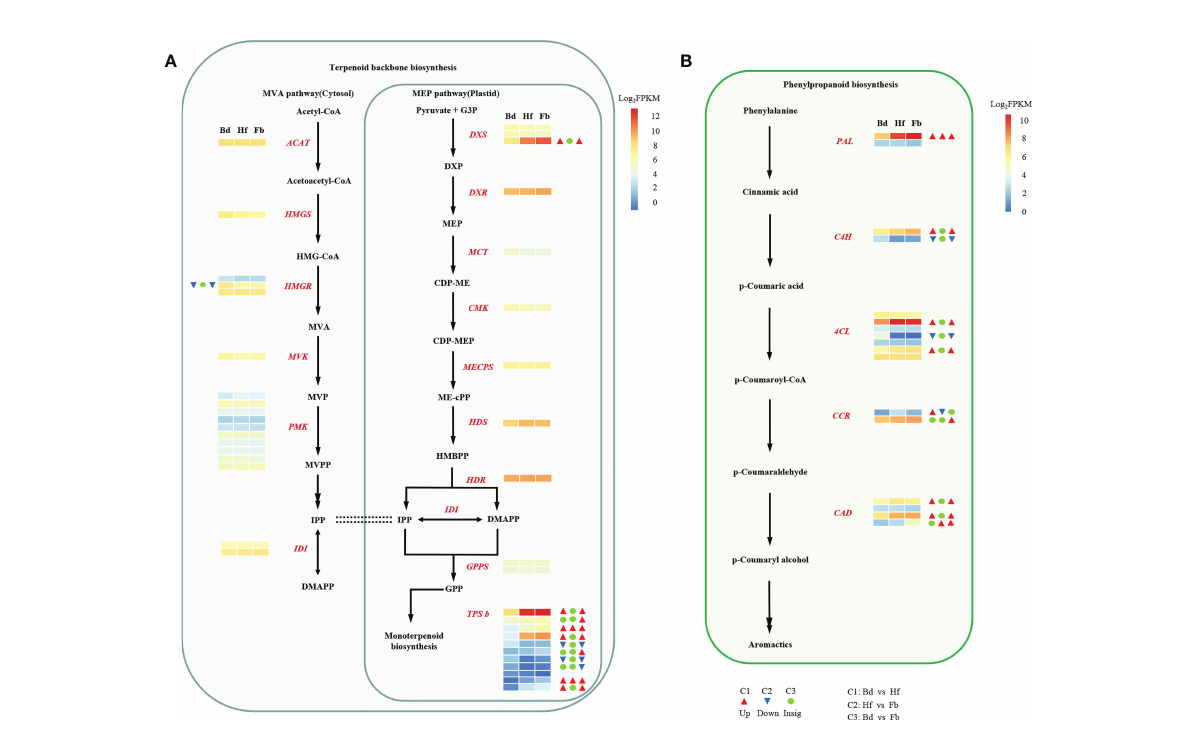
FIGURE 7 The expression pro fi les of genes encoding enzymes involved in terpenoids (A) and phenylpropanoids (B) biosynthetic pathway. Black bold font represented abbreviations of compounds: HMG-CoA, hydroxymethylglutaryl-CoA; MVA, mevalonate; MVP, mevalonate-5-phosphate; MVPP, mevalonate diphosphate; IPP, isopentenyl pyrophosphate; DMAPP, dimethylallyl pyrophosphate; G3P, glyceraldehyde 3-phosphate; DXP, 1- deoxy-D-xylulose 5-phosphate; MEP, methylerythritol phosphate; CDP-ME, 4-diphosphocytidyl-2-C-methyl-D-erythritol; CDP-MEP, CDP-ME 2-phosphate; ME-cPP, 2-C-methyl-D-erythritol 2,4-cyclodiphosphate; HMBPP, 4-hydroxy-3-methyl-but-2-enyl pyrophosphate; GPP, geranyl pyrophosphate. Red bold italicized font represented abbreviations of coding genes: AACT , acetyl-CoA acetyltransferase; HMGS , HMG-CoA synthase; HMGR , HMG-CoA reductase; MVK , mevalonate kinase; PMK , phosphomevalonate kinase; IDI , isopentenyl pyrophosphate isomerase; DXS , 1-deoxy-dxylulose-5-phosphate synthase; DXR , 1-deoxy-d-xylulose-5-phosphate reductoisomerase; MCT , 2-C-methyl-D-erythritol 4- phosphate cytidylyltransferase; CMK , 4-diphosphocytidyl-2-C-methyl-D-erythritol kinase; MECPS , 2-C-methyl-D-erythritol 2,4- cyclodiphosphate synthase; HDS , (E) -4-hydroxy-3-methylbut-2-enyl-diphosphate synthase; HDR , 4-hydroxy-3-methylbut-2-enyl diphosphate reductase; GPPS , GPP synthase; TPS , terpene synthase; PAL , phenylalanine ammonia lyase; C4H , cinnamate-4-hydroxylase; 4CL , 4-coumaroyl- CoA ligase; CCR , cinnamoyl-CoA reductase; CAD , cinnamyl-alcohol dehydrogenase. Dotted line represented equivalence, double arrows represented two steps. The three squares indicated the gene expression levels (log 2 FPKM) in (D) chrysotoxum fl owers on the stage of Bd, Hf, and Fb, which were shown by a color gradient from red to white to blue. The DEGs were marked with three triangles or circles, which indicated that the differential expression in different compassion of C1 (Bd vs. Hf), C2 (Hf vs. Fb), and C3 (Bd vs. Fb). The red triangle denoted up- regulated, the blue inverted triangle represented down-regulated, and green circle indicated no signi fi cant